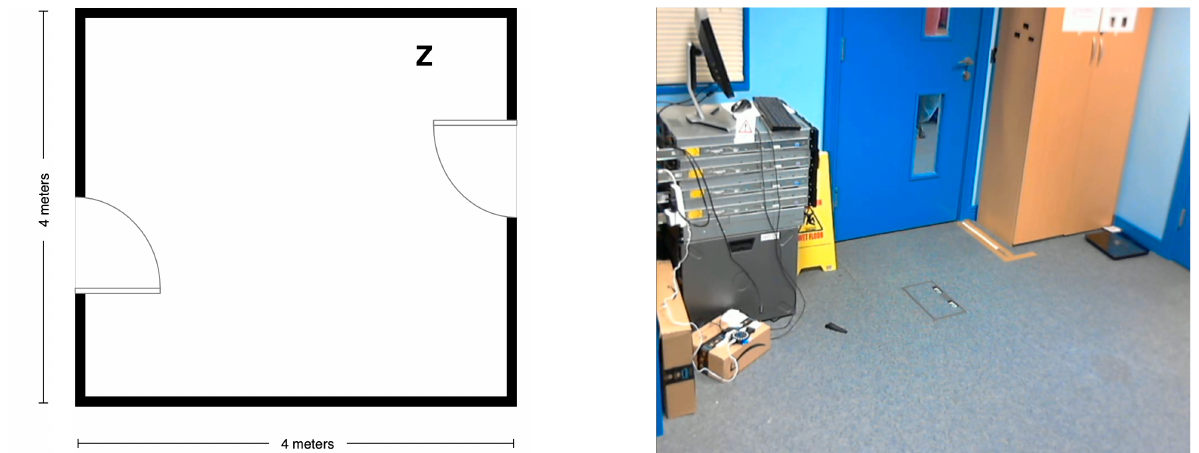
Figure 3. Sketch and photograph from the empty room mimicking a corridor. The photograph was taken from position